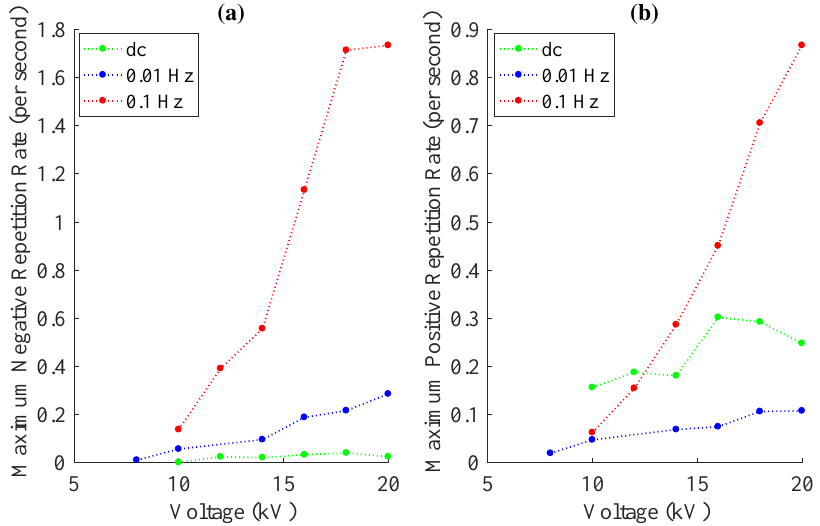
Figure 9. Voltage dependence of maximum PD repetition rate for ( a ) negative rate; ( b ) positive